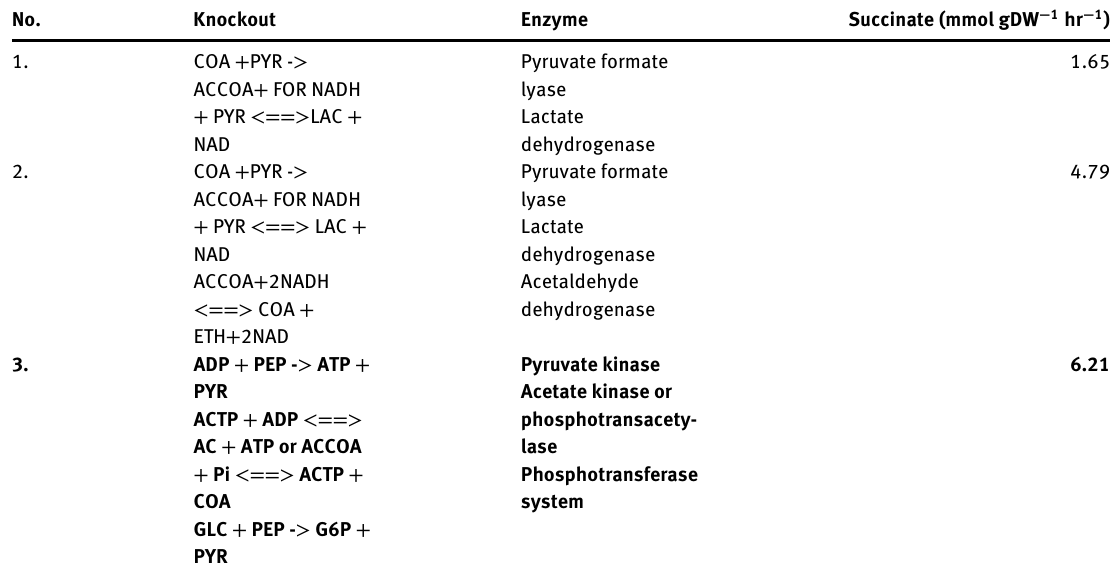
Bold font represents the best result.